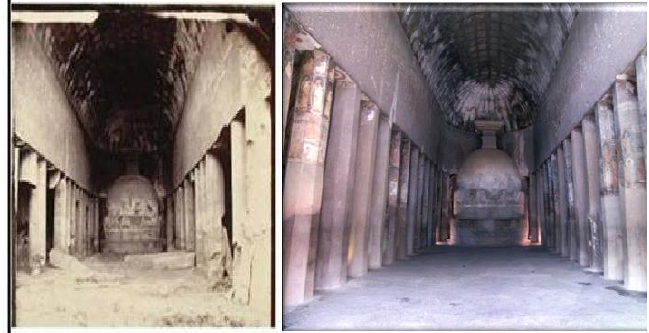
Figure 14. Before and after structural conservation measures for the cave 10,